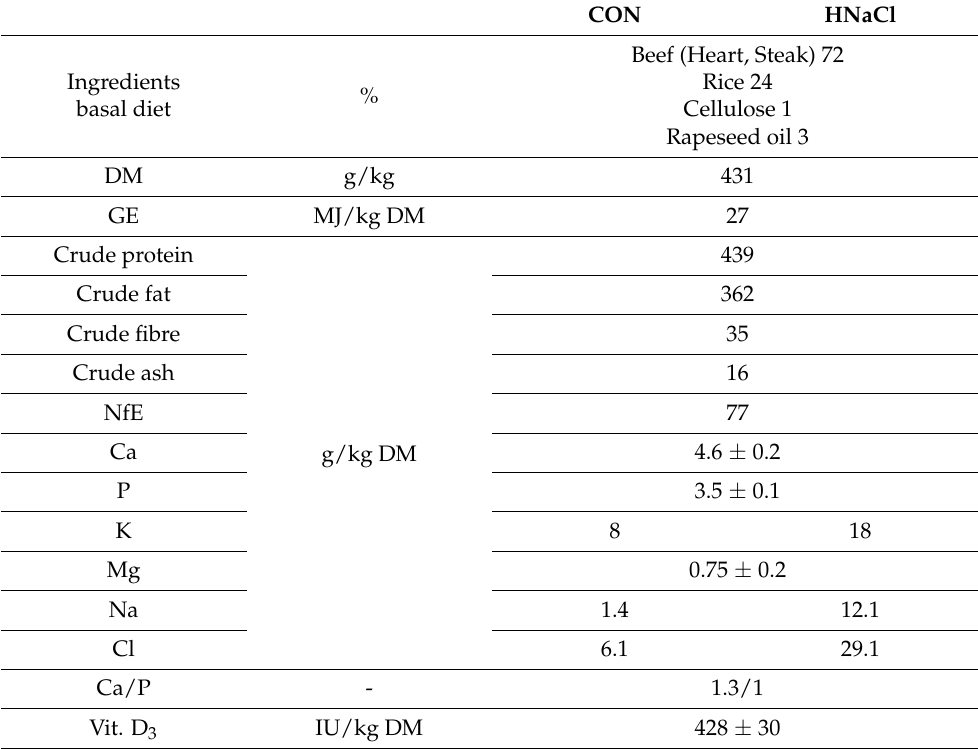
Table 1. Composition of diets.